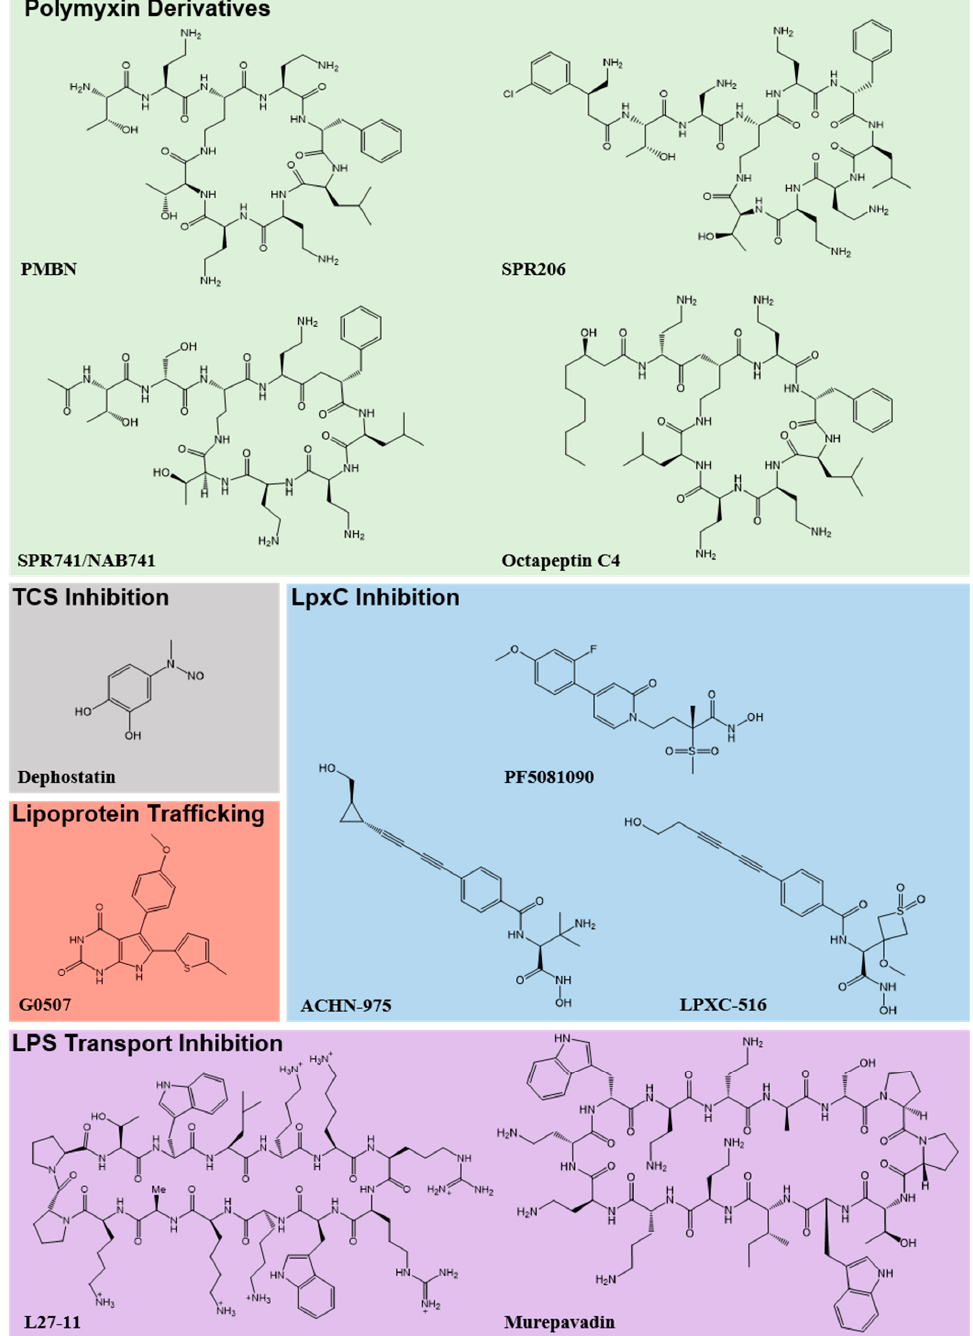
Figure 1. Outer Membrane Inhibitors. Polymyxin analogues (green), two-component system (TCS) (grey), lipoprotein tra ffi cking (red), LpxC (blue) and LPS transport (purple) inhibitors. PMBN